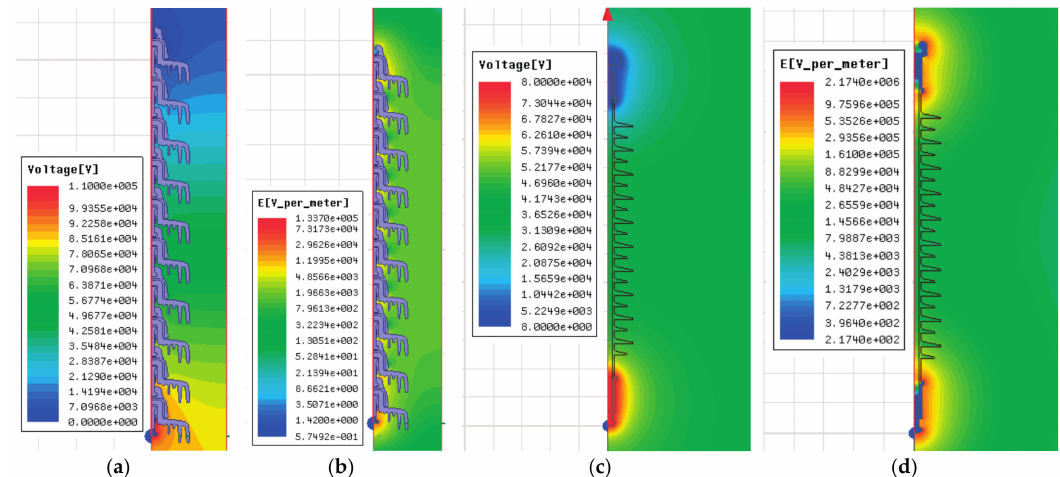
Figure 9. Insulator electric field and potential distribution. ( a ) The potential distribution of the suspension insulators; ( b ) The electric field of the suspension insulators; ( c ) The potential distribution of the composite insulators; ( d ) The electric field of the composite insulators.